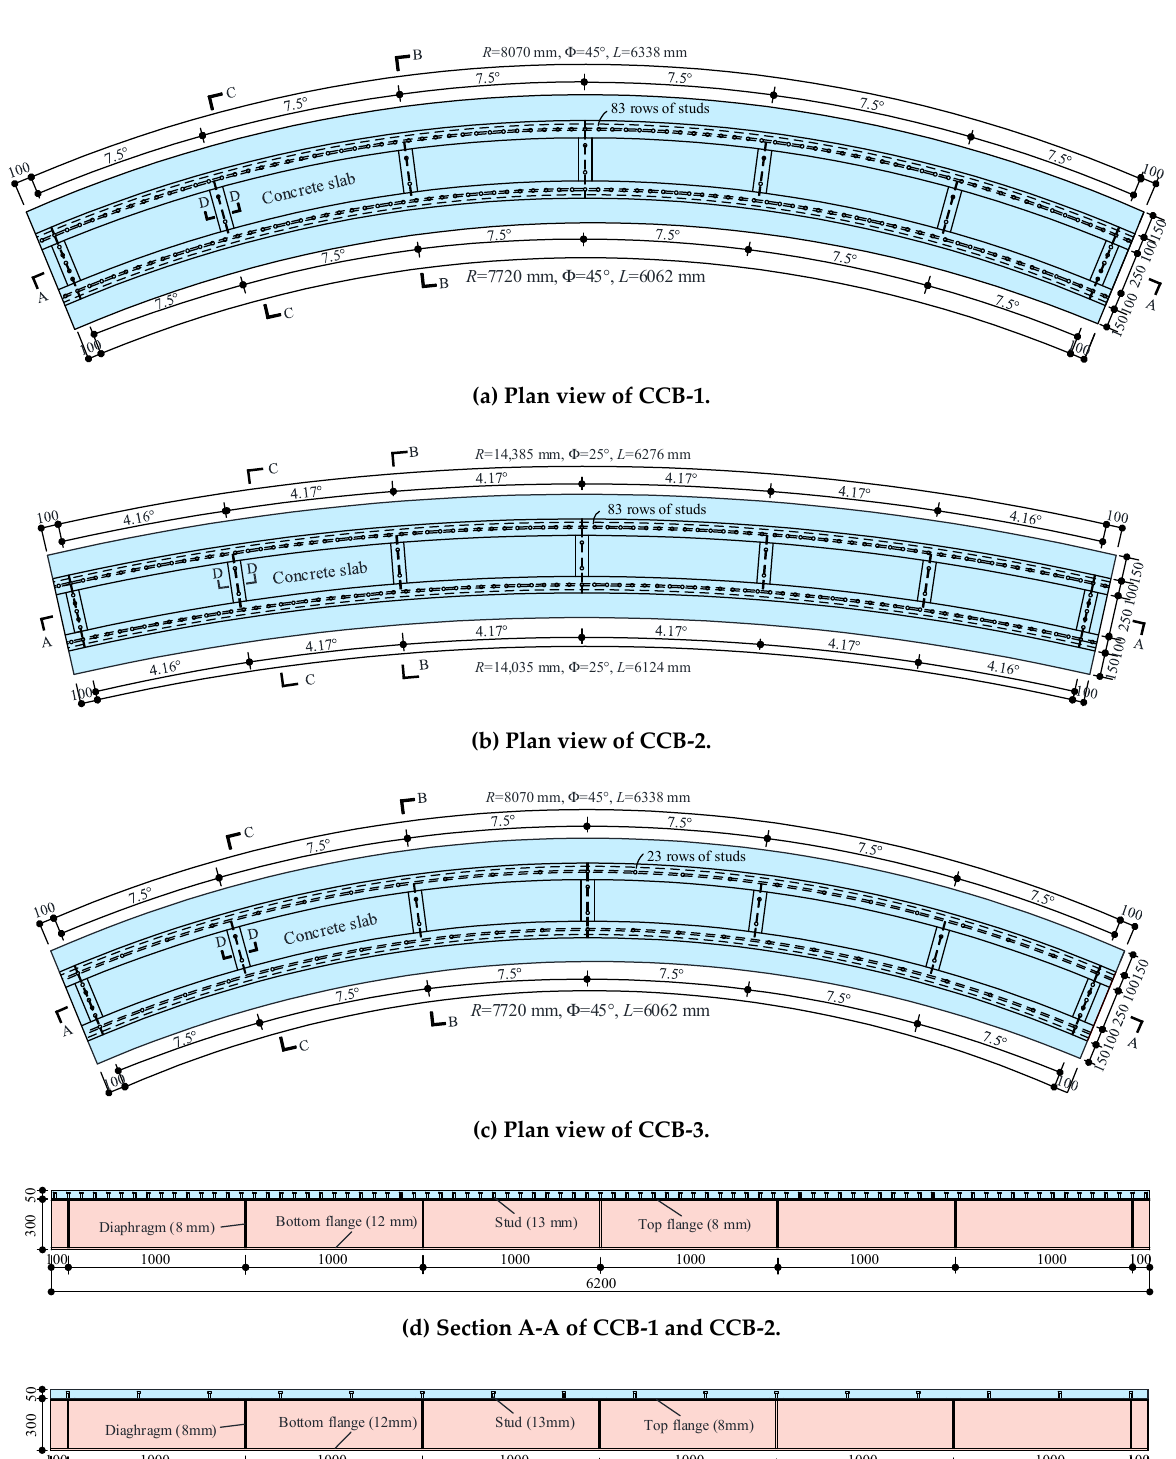
Figure 1. Schematic plots of the test specimens.